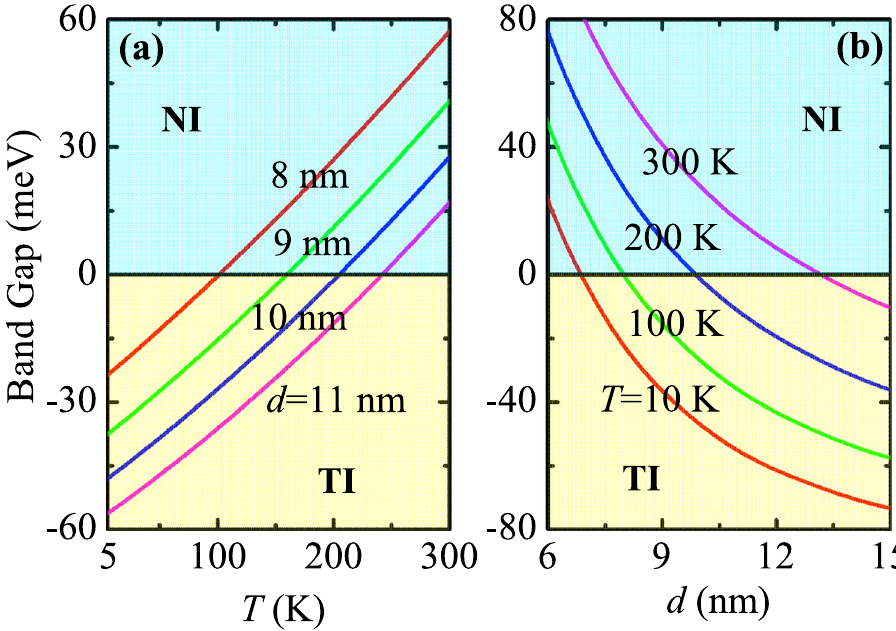
Figure 2. QW band gap as a function of thickness d (temperature T ) for different temperatures T (thicknesses d ) as indicated. Here, the light-cyan and light-yellow shadow regions denote the normal insulator (NI) phase and topological insulator (TI) phase,